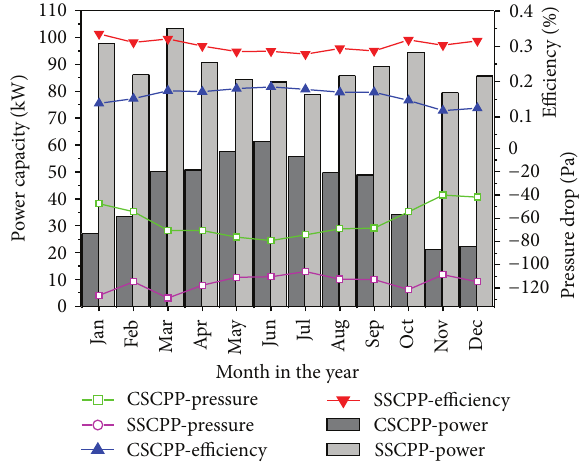
Figure 6: Pressure, efficiency, and power capacity of the CSCPP and SSCPP in each month.